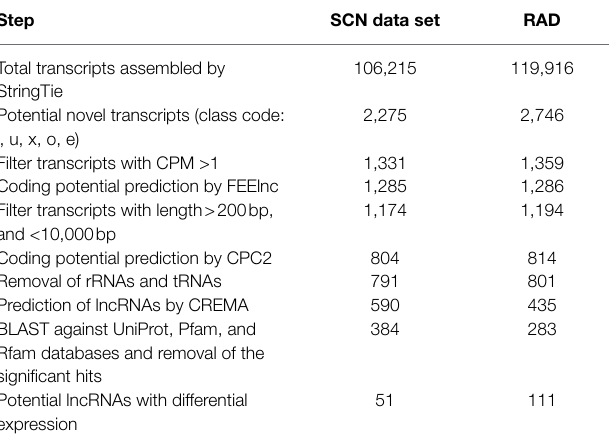
TABLE 1 | Performance of each filtering step in the lncRNA identification pipeline in SCN data set and